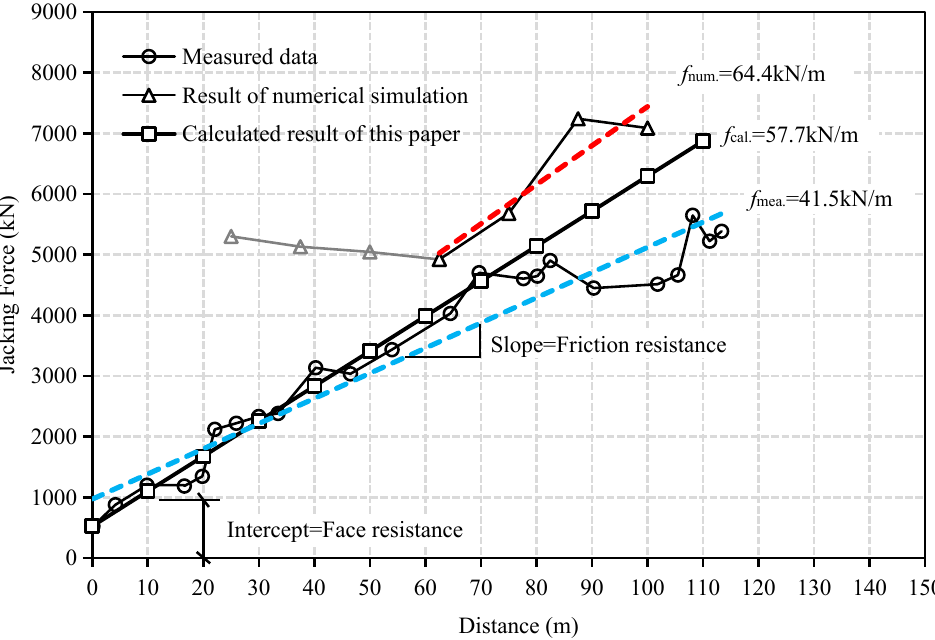
Figure 8. The comparison of jacking forces from monitoring, the numerical simulation, and the predicted equations of this paper.